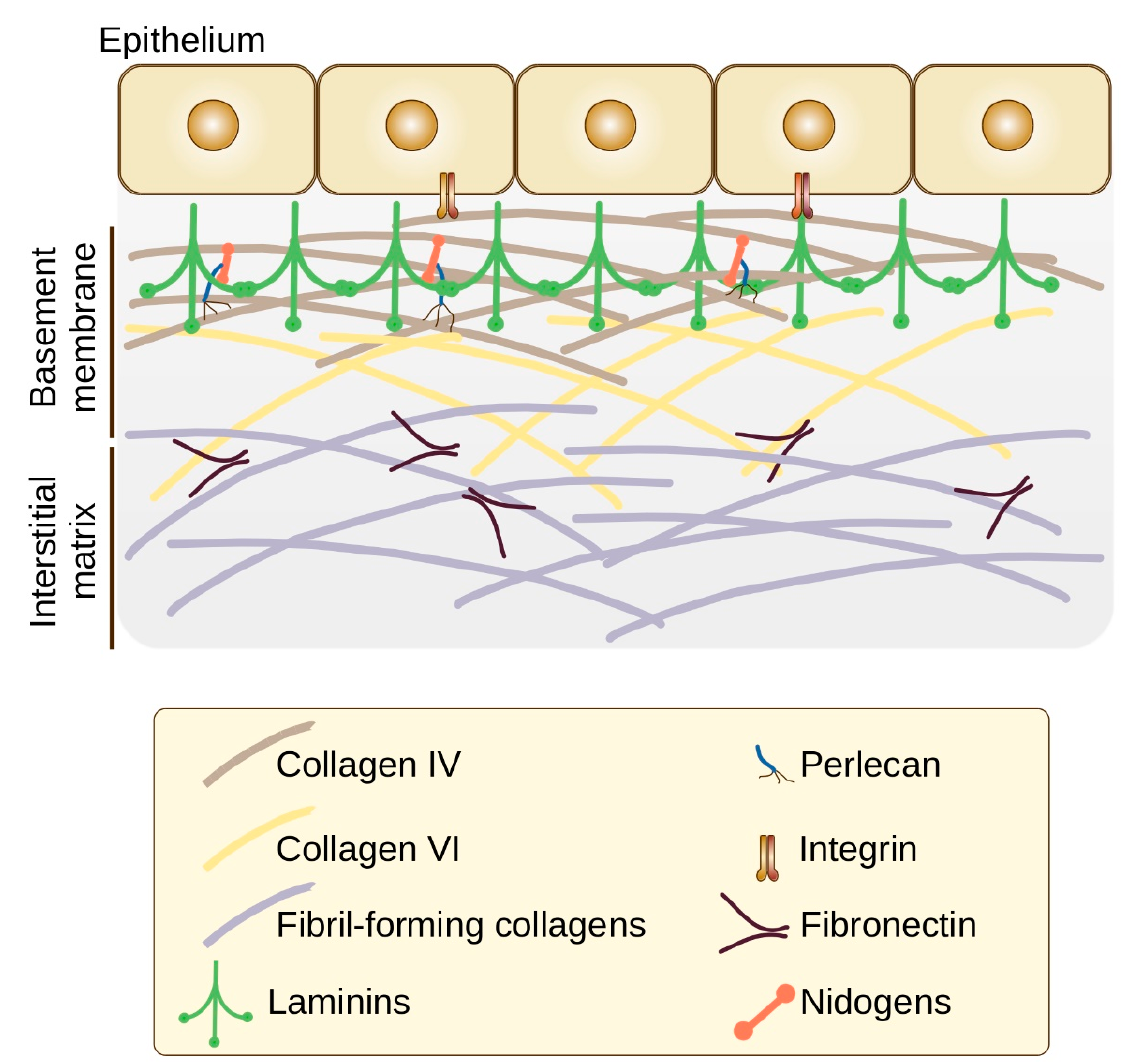
Figure 1. Schematic view of ECM organization (based on [12,17,18]). The major components of the basement membrane are the network-forming collagens (type IV collagen) and laminins. Nidogens and perlecan serve as binding bridges between the two networks: nidogens bridge laminin and collagen IV networks, and perlecan connects nidogen to collagen IV. Collagen VI interact with collagen IV, providing a link between the basement membrane and fibrillar components of the interstitial